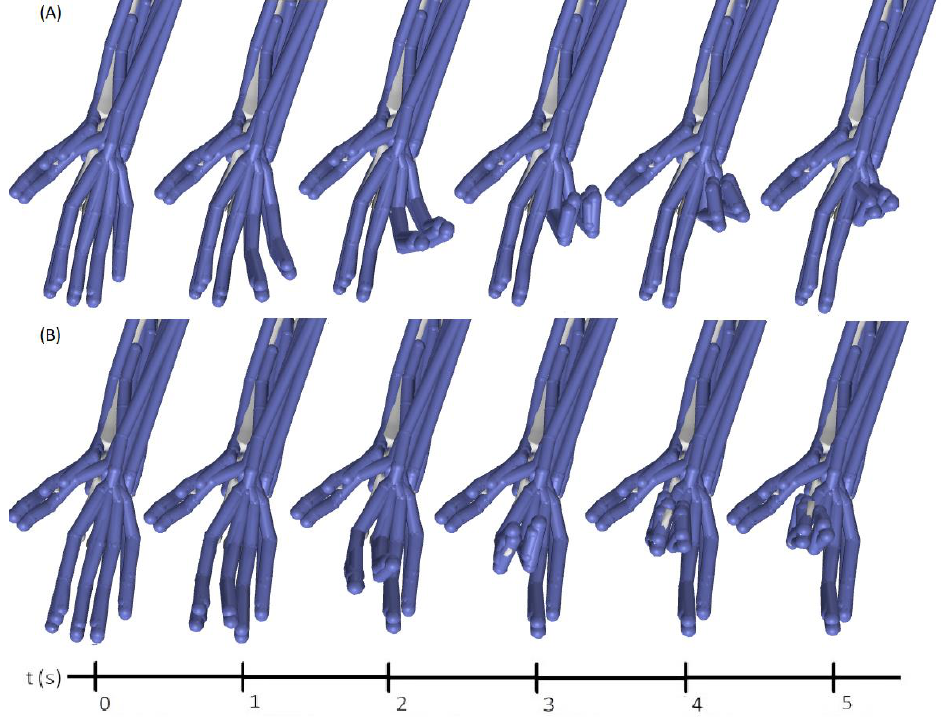
Figure 12. Reproduction of the RL movement for 5 s in Opensim: ( A ) ideal movement; ( B ) total movement of repetition 1 for the movement of subject 6, which was the worst classified.